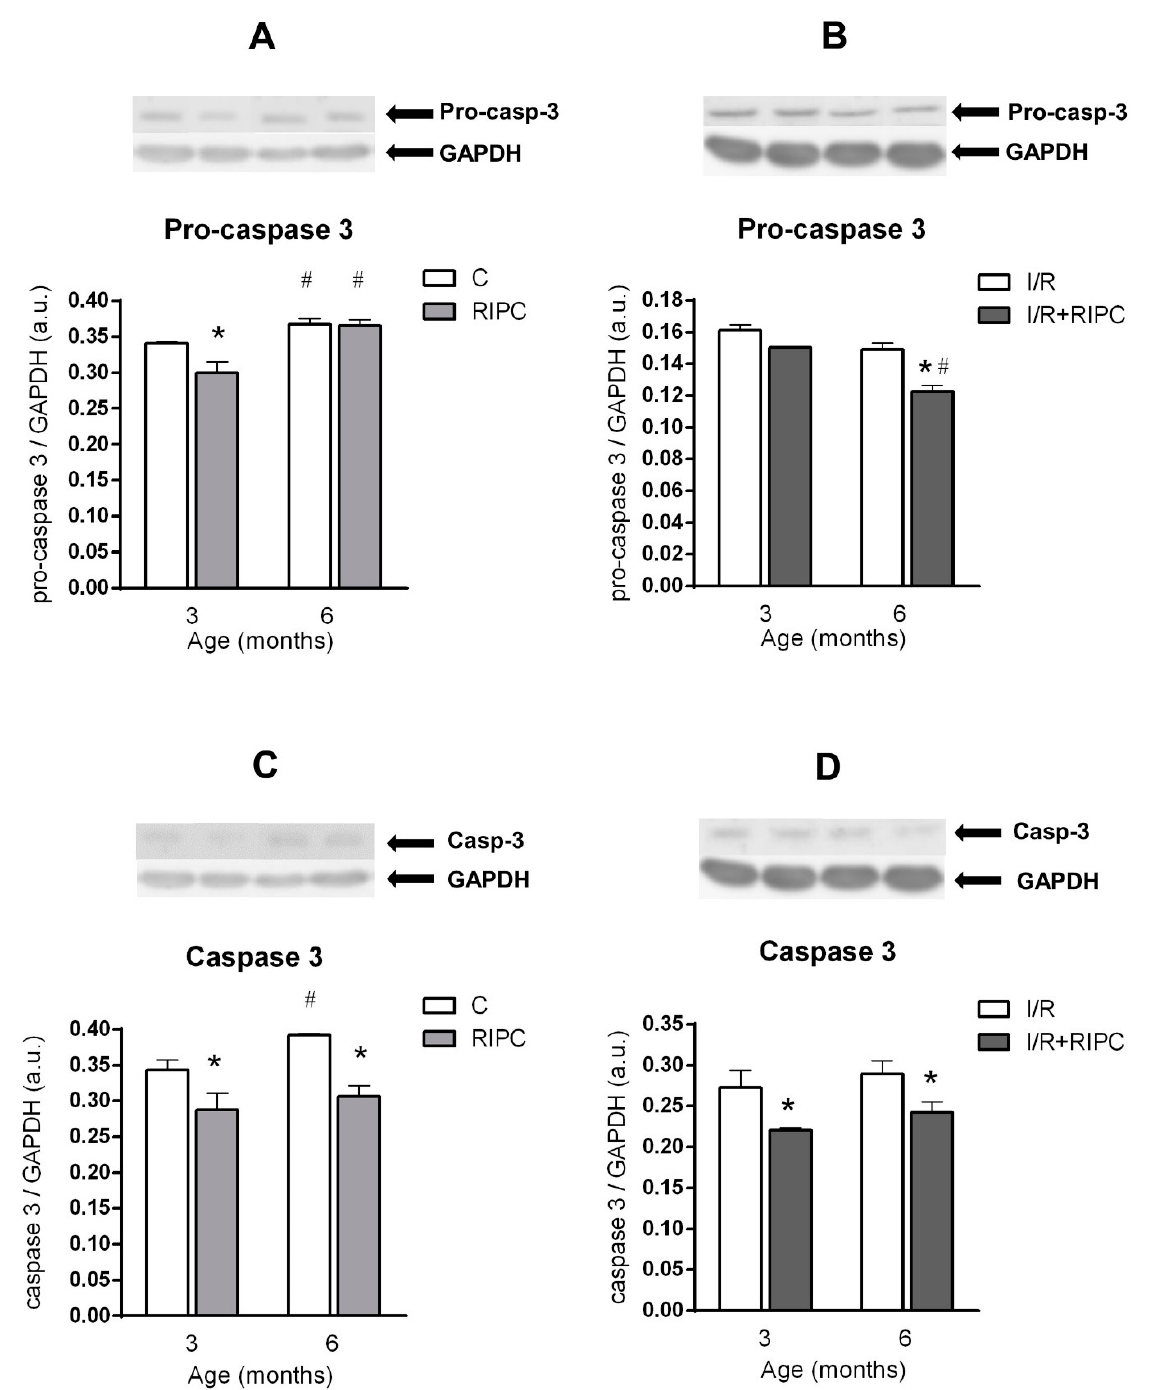
Figure 4. The effect of age and remote ischemic preconditioning on the expression of proteins involved in pro and anti- apoptotic cascades in rat myocardium at the baseline (pre-ischemic) conditions ( A , C ) and after ischemia/reperfusion ( B , D ). Samples were taken prior to ischemia (20 min stabilization perfusion) and at 40 min of post-ischemic reperfusion. ( A , B )—pro-caspase 3, ( C , D )—caspase 3. ( C )—baseline samples, I/R—post-IR samples, RIPC—samples with prior remote ischemic preconditioning. Data are presented as means ± S.E.M of 4–5 hearts per group, normalized to the levels of GAPDH. * p < 0.05 RIPC vs. C; # p < 0.05 vs. 3 months.